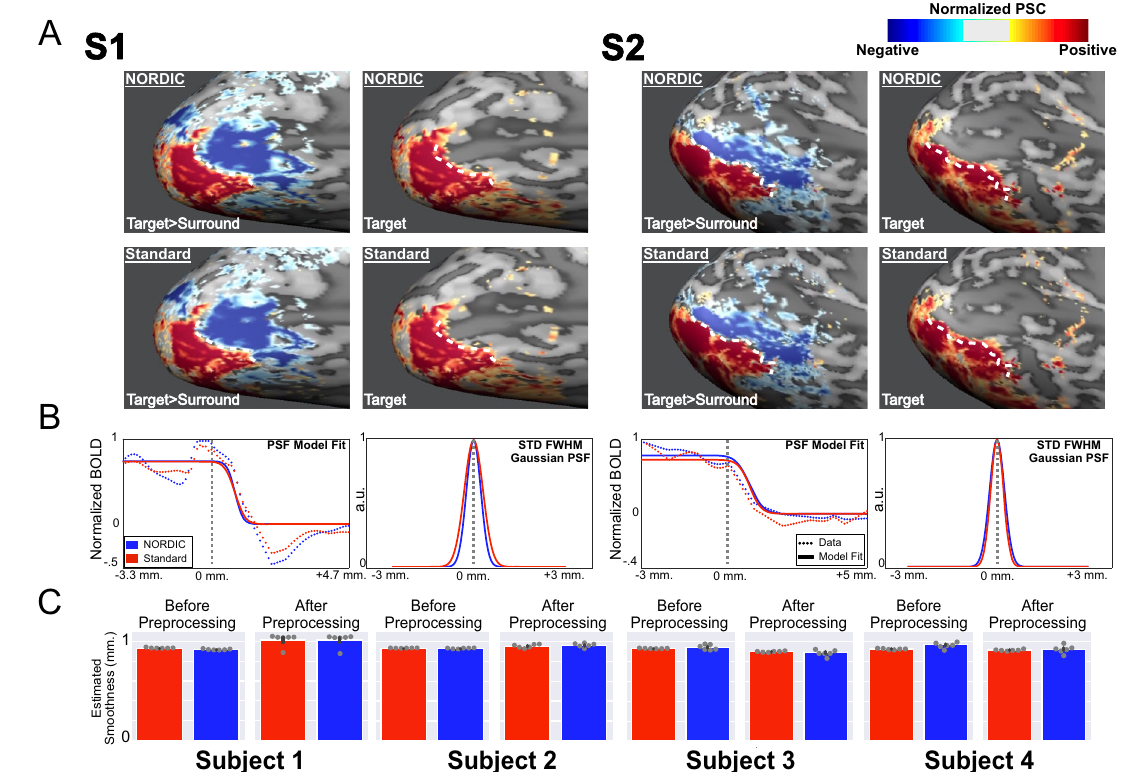
Fig. 5 Functional point spread function (PSF) and global image smoothness. Panel A , top row shows NORDIC normalized beta percent signal change (PSC) maps for differential mapping target (in red) > surround (in blue) (left), and the target only (right) single-condition image for subjects 1 and 2. The white dotted line is determined in the differential image as the “ boundary ” between the two stimulations. The same white dotted line is also superimposed on the target-only PSC map where PSC values are greater than zero but decreasing in magnitude progressively away from this “ boundary ” posteriorly. The functional PSF is calculated from this spread in PSC beyond the “ boundary ” . Panel A , the lower row is identical to the upper row but obtained from Standard reconstruction data. Panel B left panel for each subject: the PSC magnitude changes (normalized to the highest value) along traces perpendicular to the “ boundary ” are displayed as the average (across traces and runs). The model fi ts (solid line) and data (dotted line) are shown for both the NORDIC (blue) and Standard (red) reconstructions. The vertical gray dotted line represents the “ boundary ” as derived from the differential maps. Panel B , right panel for each subject portrays the full-width at half maximum (FWHM) standard deviation of the gaussian kernel that was convolved with a step function to model functional PSF (see the “ Methods ” section). Panel C : Mean global smoothness of images used for the fMRI time series for Standard (red) and NORDIC (blue) in four subjects, before (left panel) and after preprocessing related interpolations. Error bars represent the standard error of the mean across 6 independent runs (shown as gray dots). Source data are provided as a source Data fi